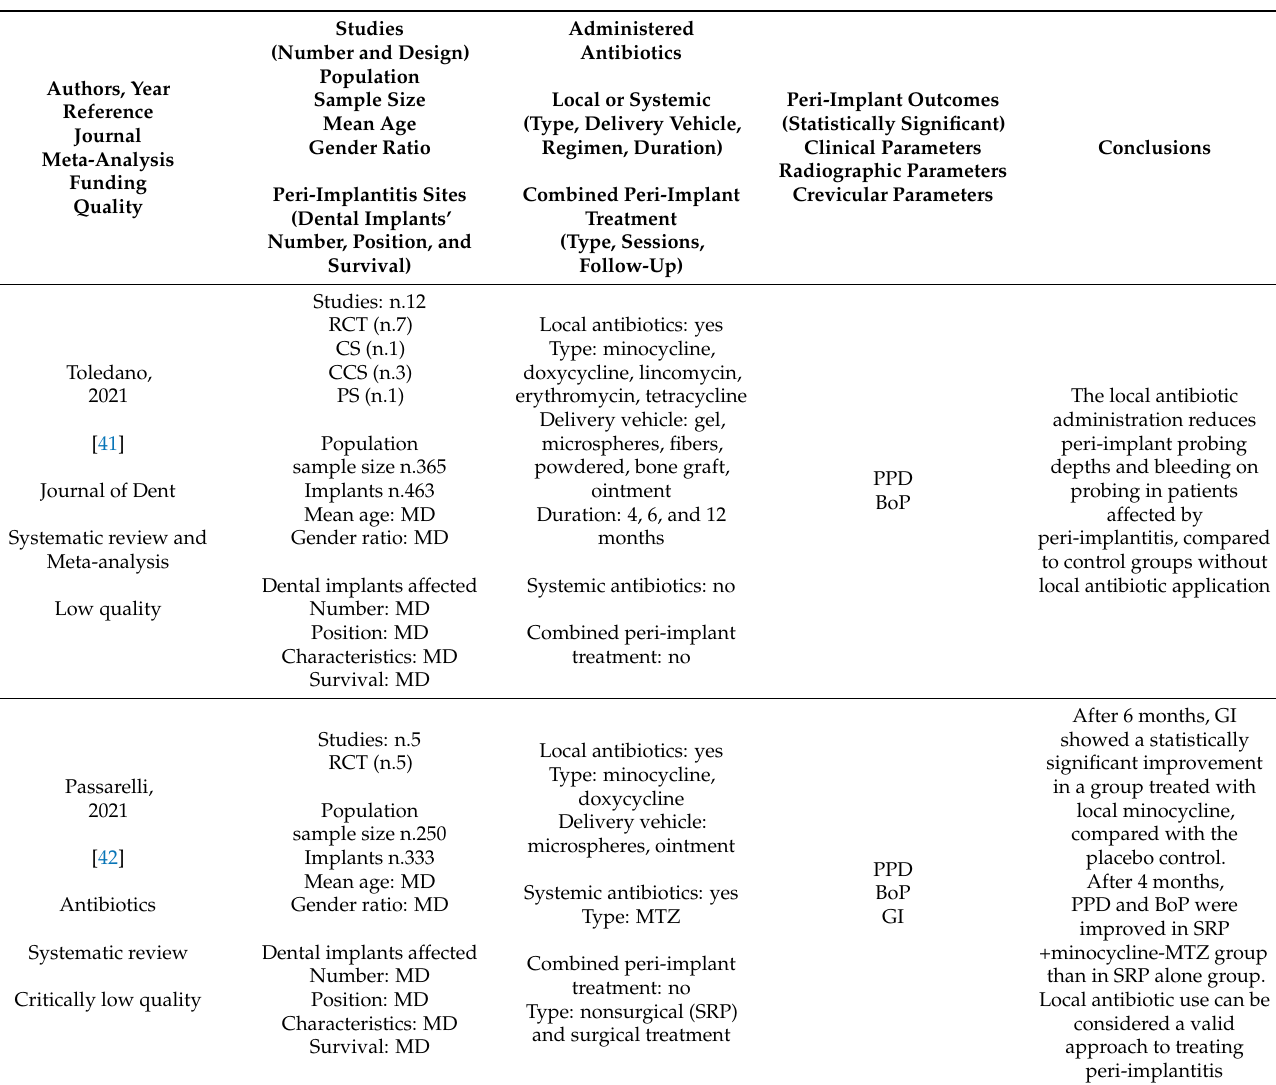
Table 3. Characteristics and outcomes from included studies. Source: first author, year, reference, journal of publication, meta-analysis, funding, and study quality (if any). Studies reported the systematic reviews included in the present umbrella review: design and number; population sample size (n.), mean age (y.o.), and gender ratio (M/F); dental implant number, position, and survival. Type, route of administration, regimen, and duration of locally- and/or systemically-delivered antibiotics alone or in combination with other (surgical or nonsurgical) peri-implantitis treatment. Clinical, radiographic, and crevicular peri-implant outcomes (statistically significant).